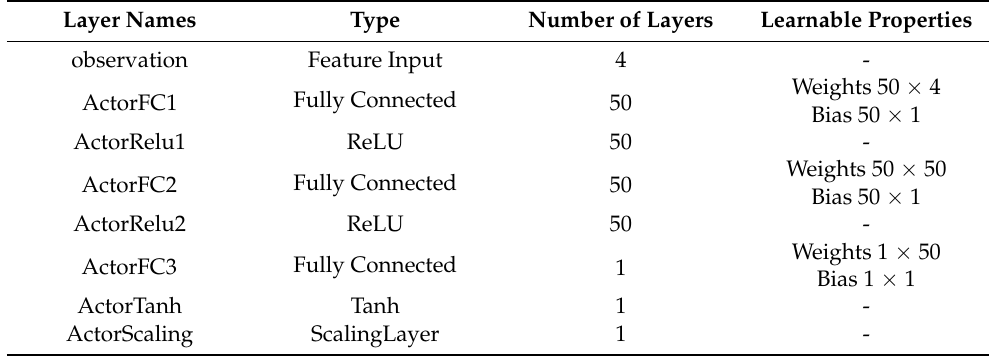
Table 2. Characteristics of the actor neural